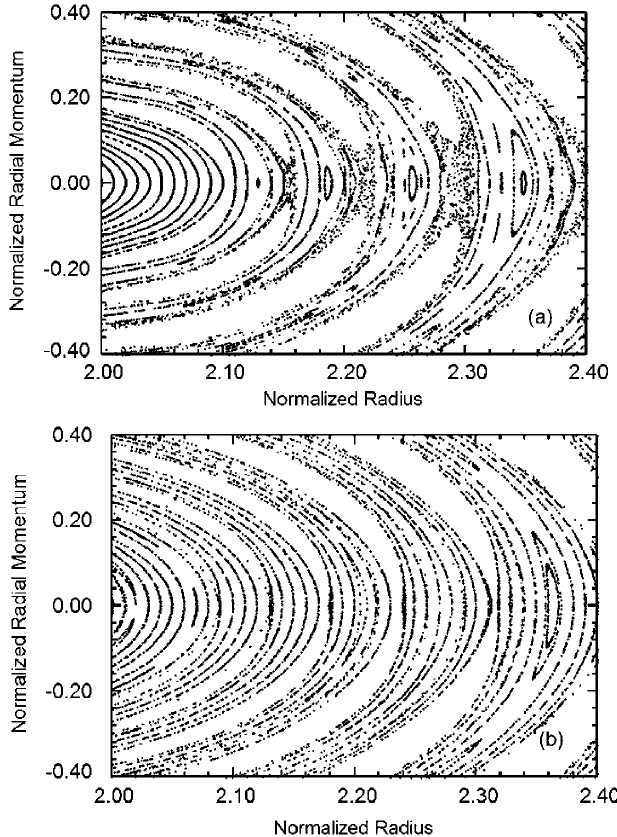
FIG. 4. Close-ups of Poincare´ surface-of-section maps of charged-particle trajectories for the two cases shown in Fig.